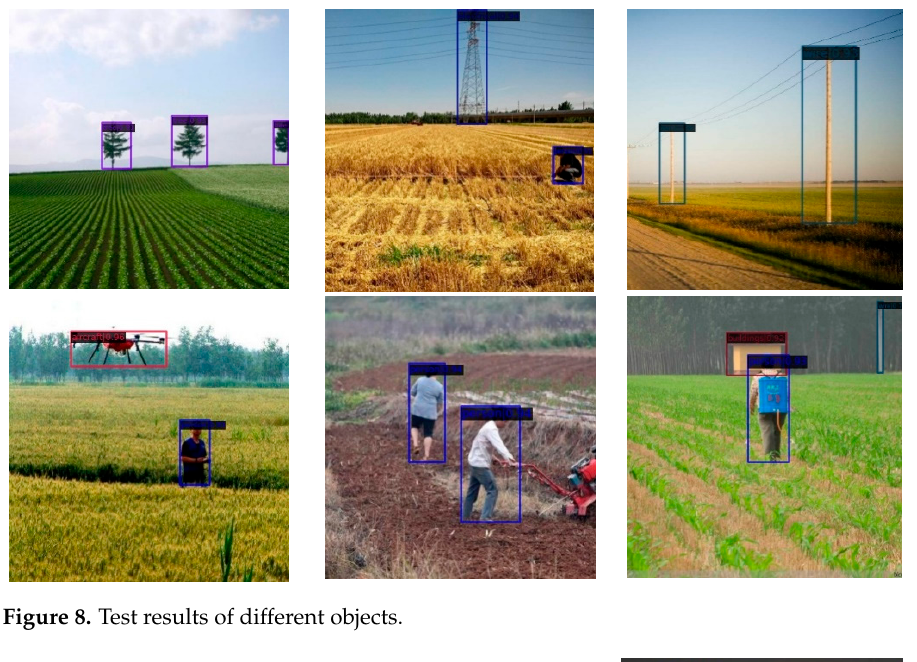
Figure 8. Test results of different objects.